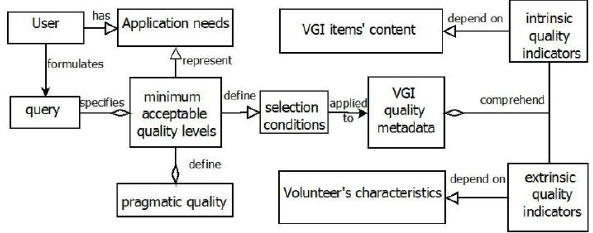
Figure 1: ontology representing the proposed user’s driven quality-based selection of VGI items